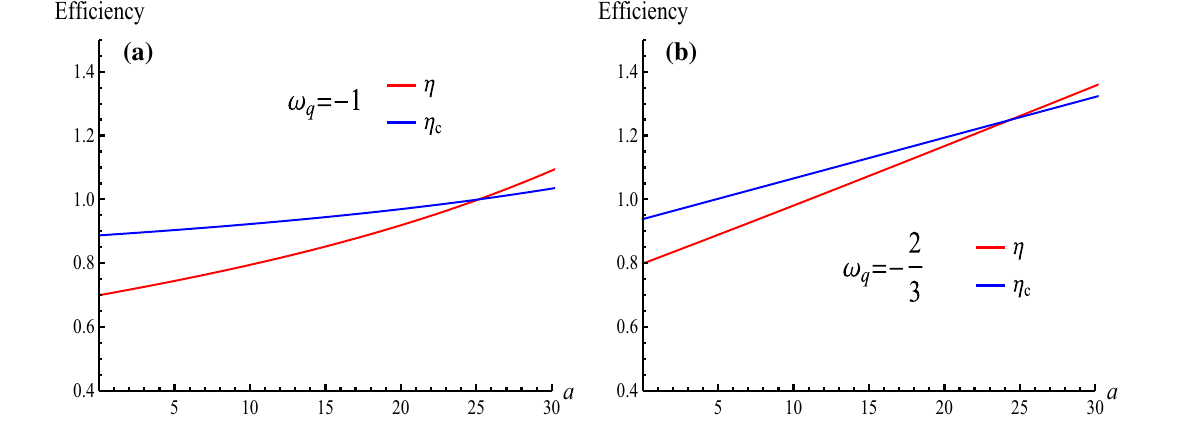
Fig. 11 a The left plot is plotted by specifying T 1 = 30, T 2 = 80, P 1 = P 2 = 10, P 3 = P 4 = 3, charge Q = 1 and state parameter ω q = − 1. b The right plot is plotted by specifying T 1 = 3, T 2 = 10, P 1 = P 2 = 0 . 5, P 3 = P 4 = 0 . 1, charge Q = 1 and state parameter ω q = − 2